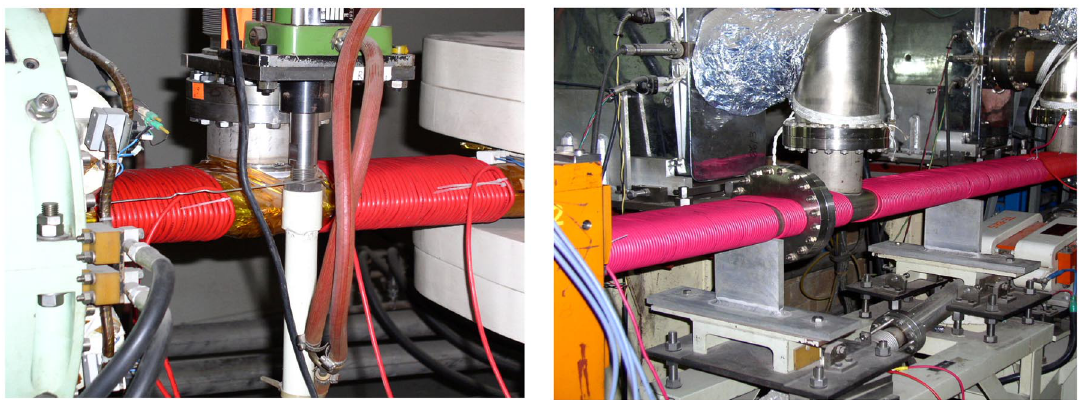
FIG. 4. (Color) The solenoid wound on the vacuum chamber.